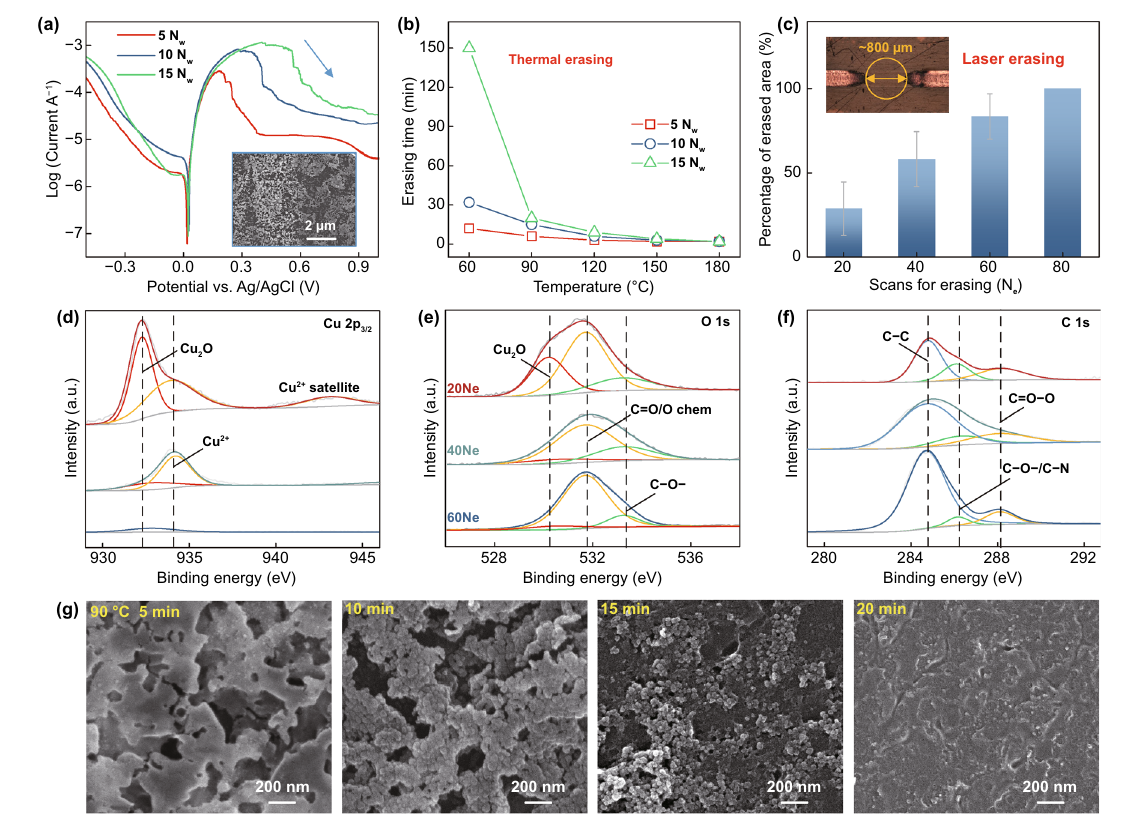
Fig. 3 Erasing mechanism and structural change. a Tafel polarization curves of the patterns obtained at different N w in HNO 3 solution (pH = 2.5). Inset SEM image shows the morphology of the typical pattern after electrochemical test. b Erasing time of the patterns obtained at different N w during thermal erasing with various temperatures. c Erased area percentage of the pattern obtained at 10 N w as a function of Ne. Inset shows the morphology of the pattern obtained at 10 N w with a full erasing area of about 0.25 mm 2 after 80 N e d Compositions of the pat- tern as a function of N e . e Surface morphologies change of the pattern during thermal